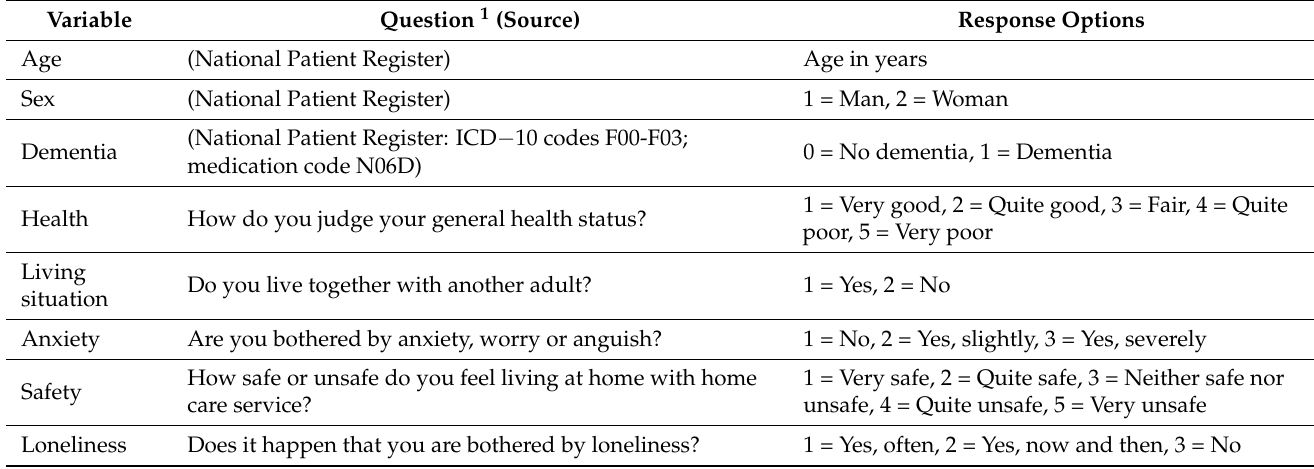
Table 1. List of